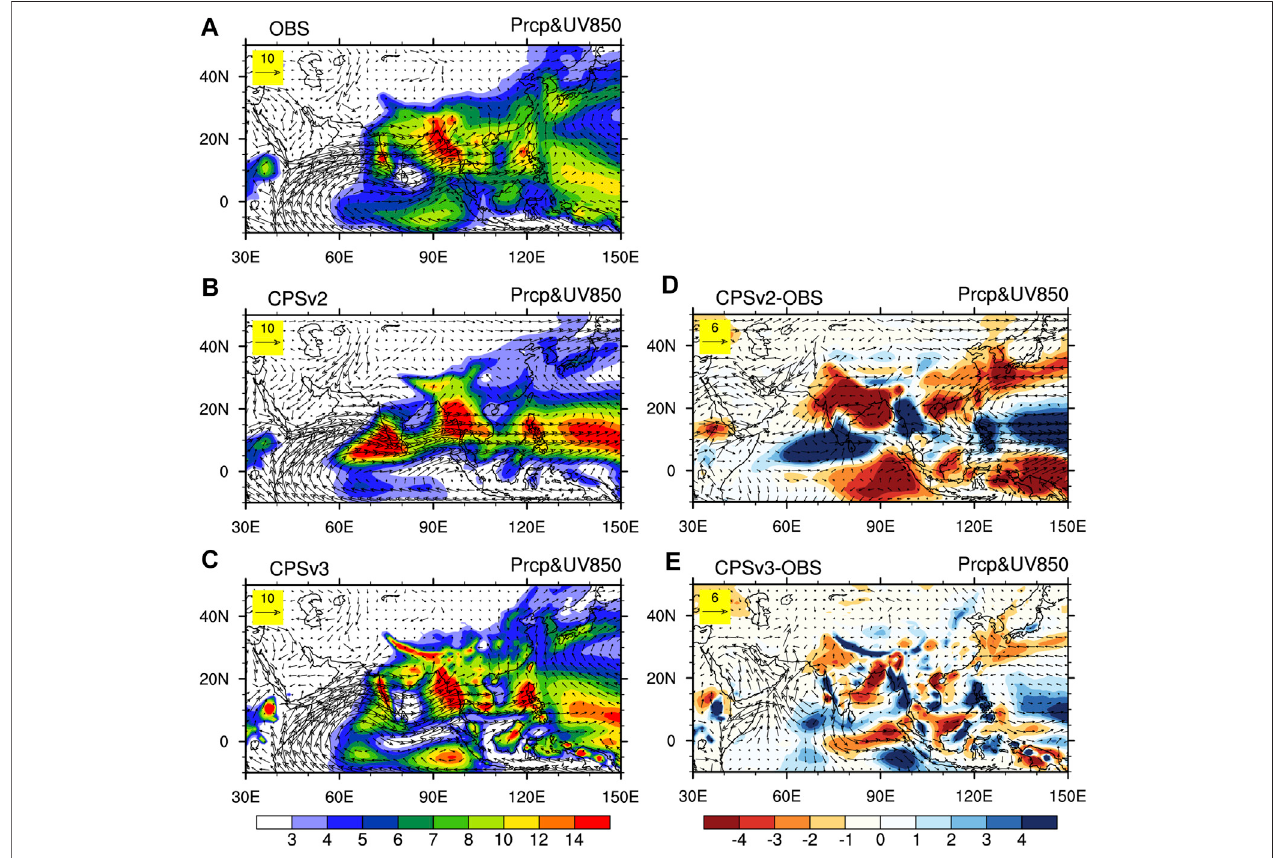
FIGURE 1 | Climatology of JJA rainfall (mm day − 1 , shading) and 850 hPa winds (m s − 1 , vectors) from (A) observation, (B) CPSv2, and (C) CPSv3 hindcasts. Also, climatological biases of (D) CPSv2 and (E) CPSv3 hindcasts.